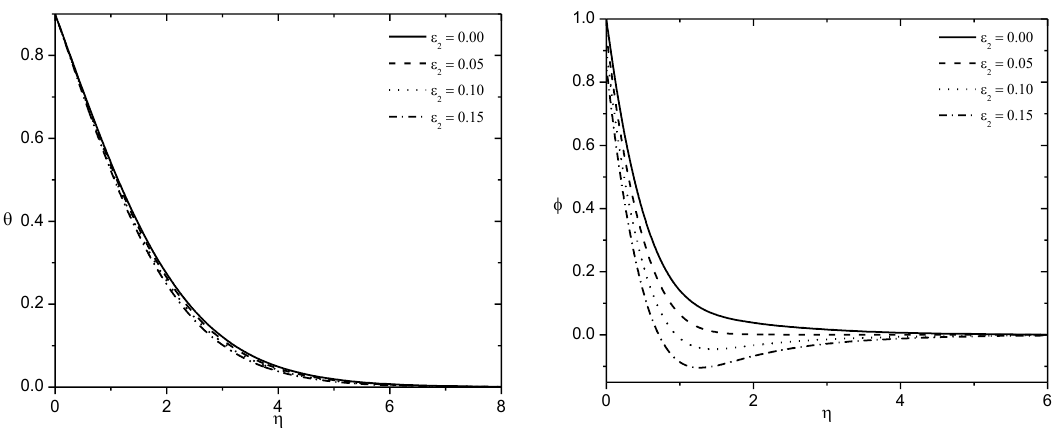
 on the Solid volume fraction Figure 10. Effet of Figure 9. Effet of 1